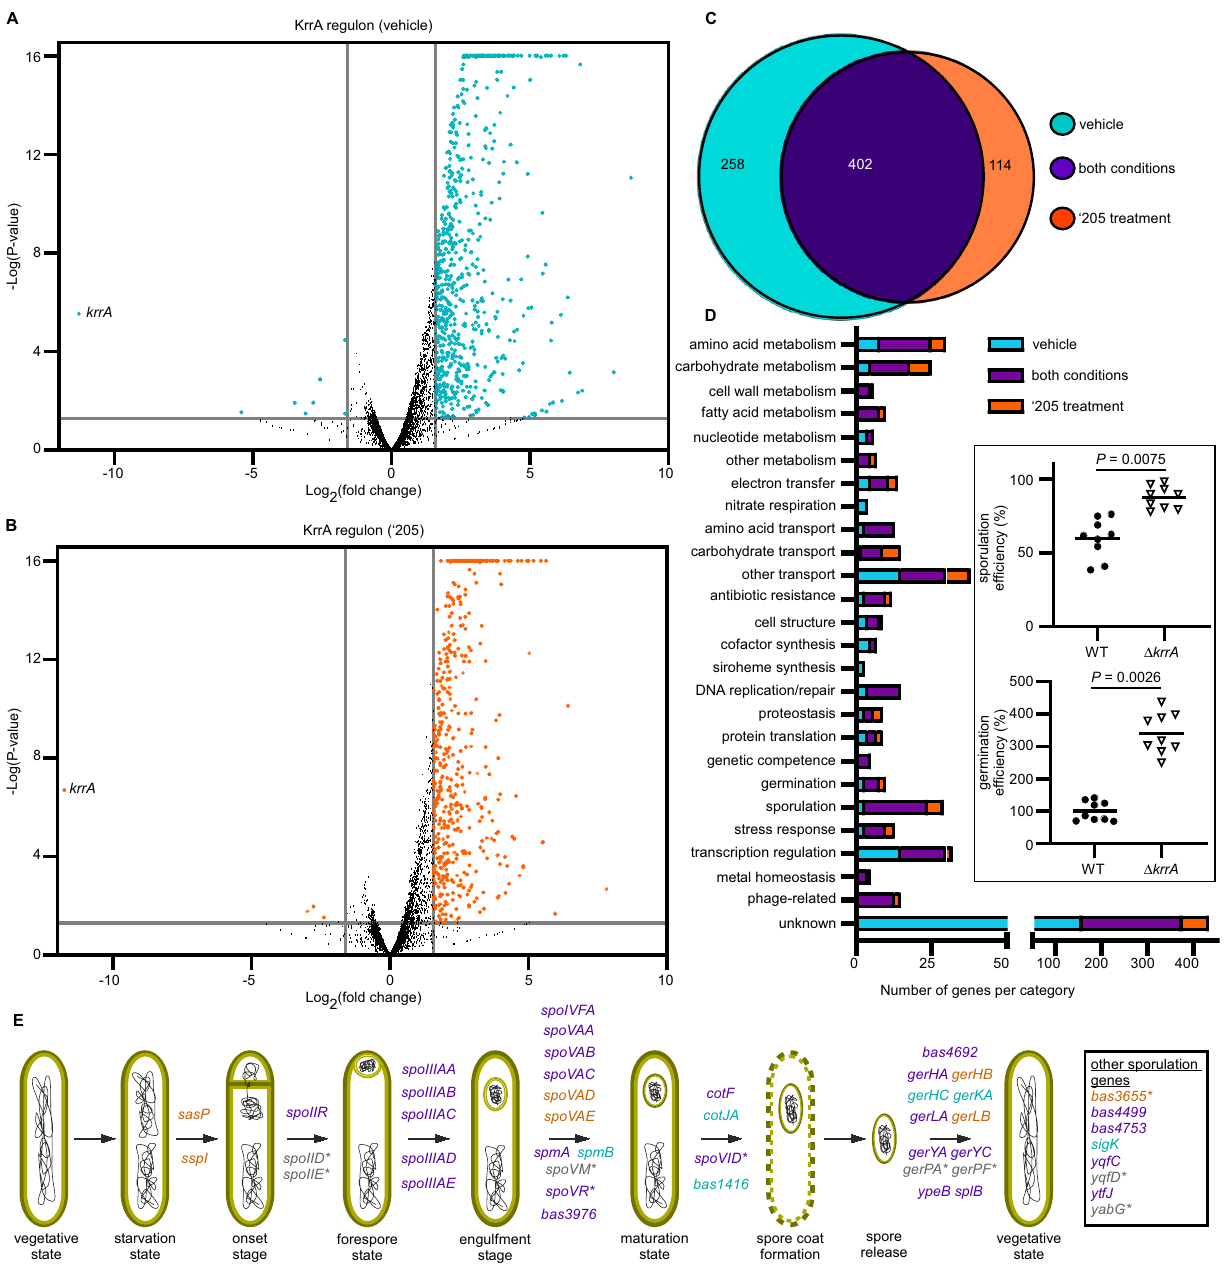
Fig. 5 KrrA-mediated RNA regulation negatively affects the abundance of numerous transcripts. Volcano plot showing transcriptomic comparison between B. anthracis Δ krrA and WT following vehicle ( A ) or 50 µ M ‘ 205 treatment ( B ). Genes with signi fi cantly different expressions are highlighted in cyan ( A ) or orange ( B ). The fold change cutoff is ≥ 3 and the P value cutoff is <0.05, both of which are indicated by gray lines. C Overview of KrrA targets revealed by RNA-seq under vehicle or ‘ 205-treated conditions. D Genes identi fi ed in the RNA-seq analysis with signi fi cantly differential expression grouped into predicted functional categories. Inset: Ef fi ciency of sporulation and germination was further examined in B. anthracis WT and Δ krrA . Data shown are three independent experiments with three replicates each time (mean ± SEM; n = 9). Signi fi cant differences are determined by two-tailed t tests. E The key stages in the cycle of sporulation and germination showing all genes with signi fi cantly elevated expression identi fi ed from RNA-seq under vehicle- (cyan), ‘ 205-treated (orange), or both conditions (purple). Other genes that have not been characterized for any speci fi c stage are listed in the box. Additional genes with minor changes in expression but identi fi ed from RIP-seq are shown in gray. The genes enriched by KrrA immunoprecipitation (RIP-seq) are denoted by